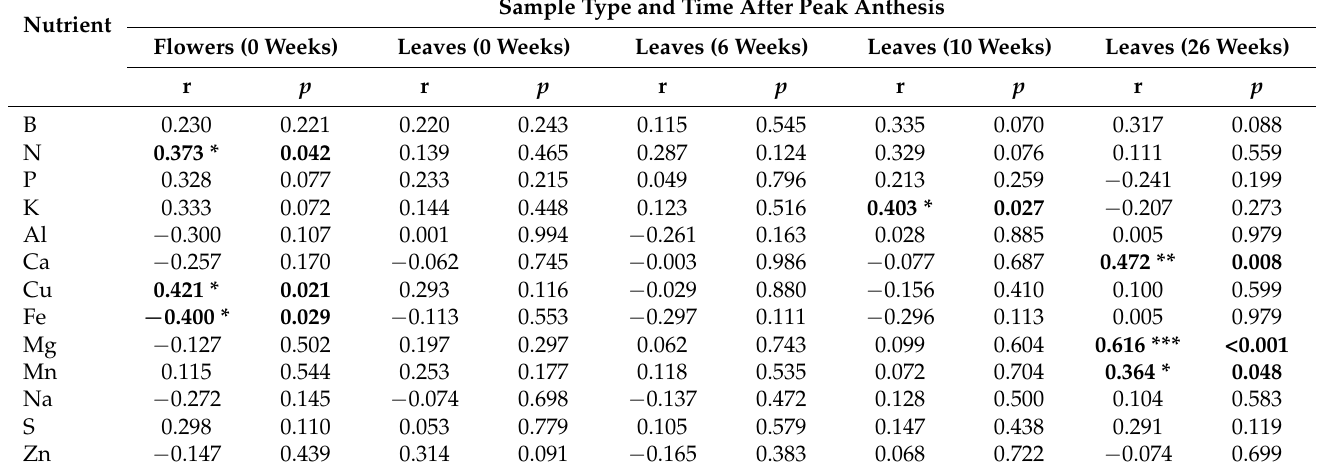
Table 2. Relationships between kernel yield and floral or foliar mineral nutrient concentrations at 0, 6, 10 or 26 weeks after peak anthesis in macadamia cultivar ‘816’ trees treated with 0, 15 or 30 g B prior to flowering.